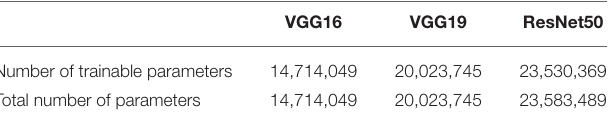
TABLE 4 | Number of parameters of the DL